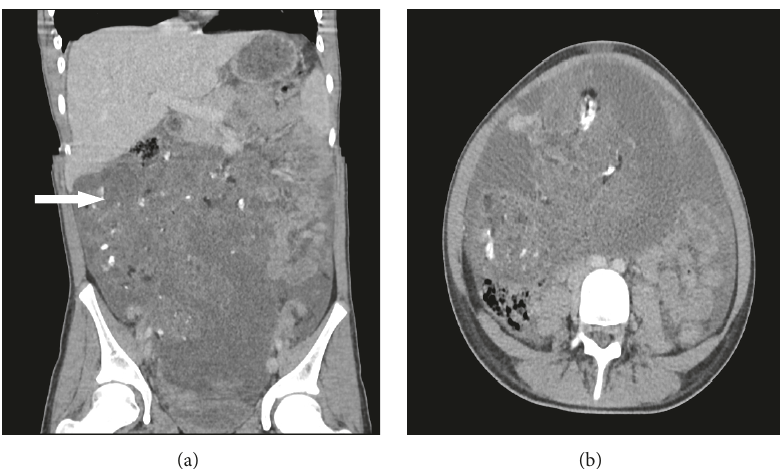
Figure 1: Initial imaging computed tomography of the abdomen and pelvis demonstrating a large pelvic tumor (arrow).